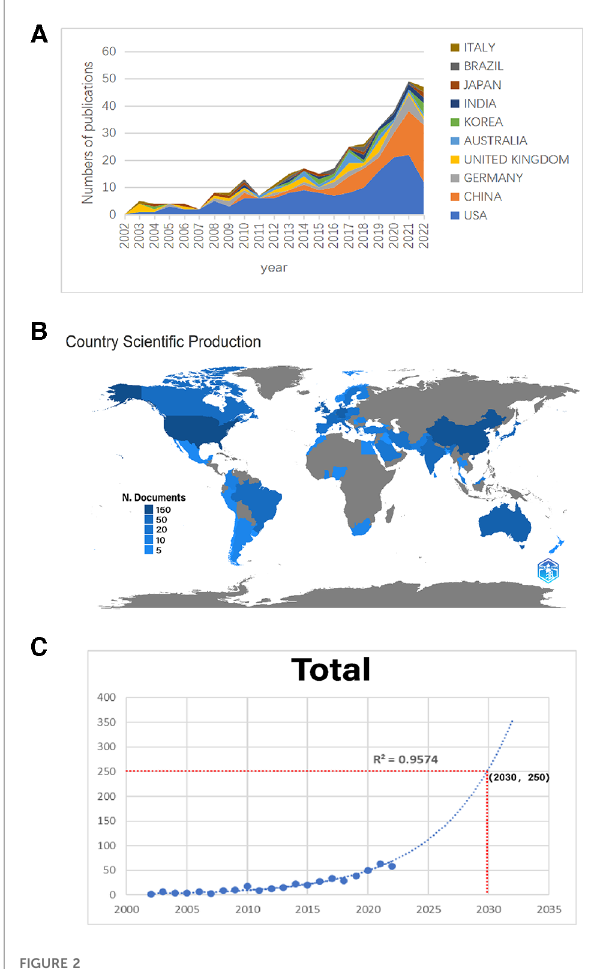
FIGURE 2 ( A ) The number of publications by year over the past 20 years. ( B ) Distribution of scienti fi c production numbers between countries in the world map. ( C ) Curve fi tting of the total annual growth trend of publications ( R 2